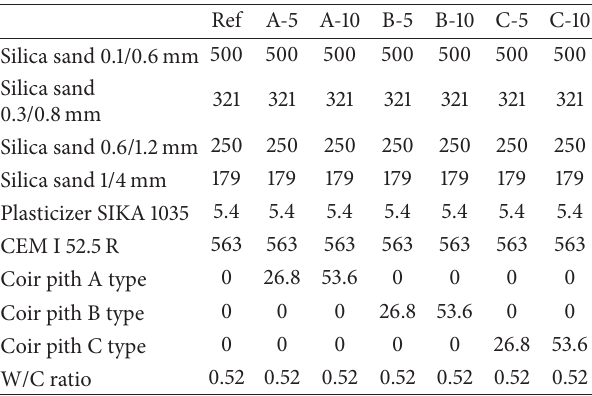
Table 1: Composition of concrete mixtures (kg/m 3 ).